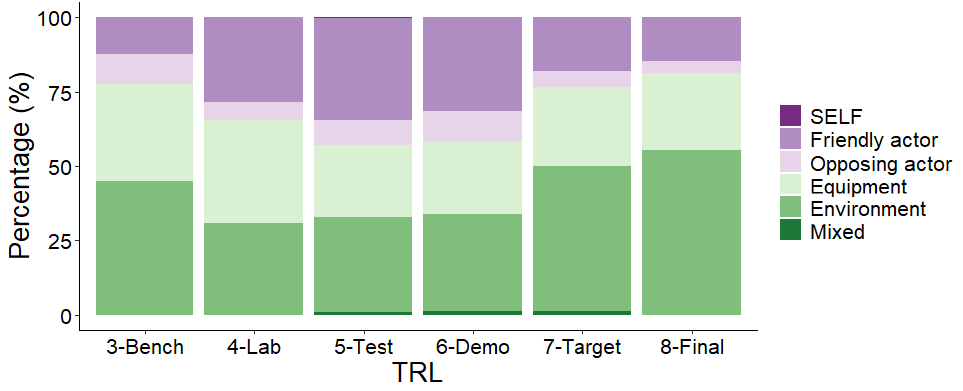
Figure 12. Deployment distribution between TRL and subject of the goal network.